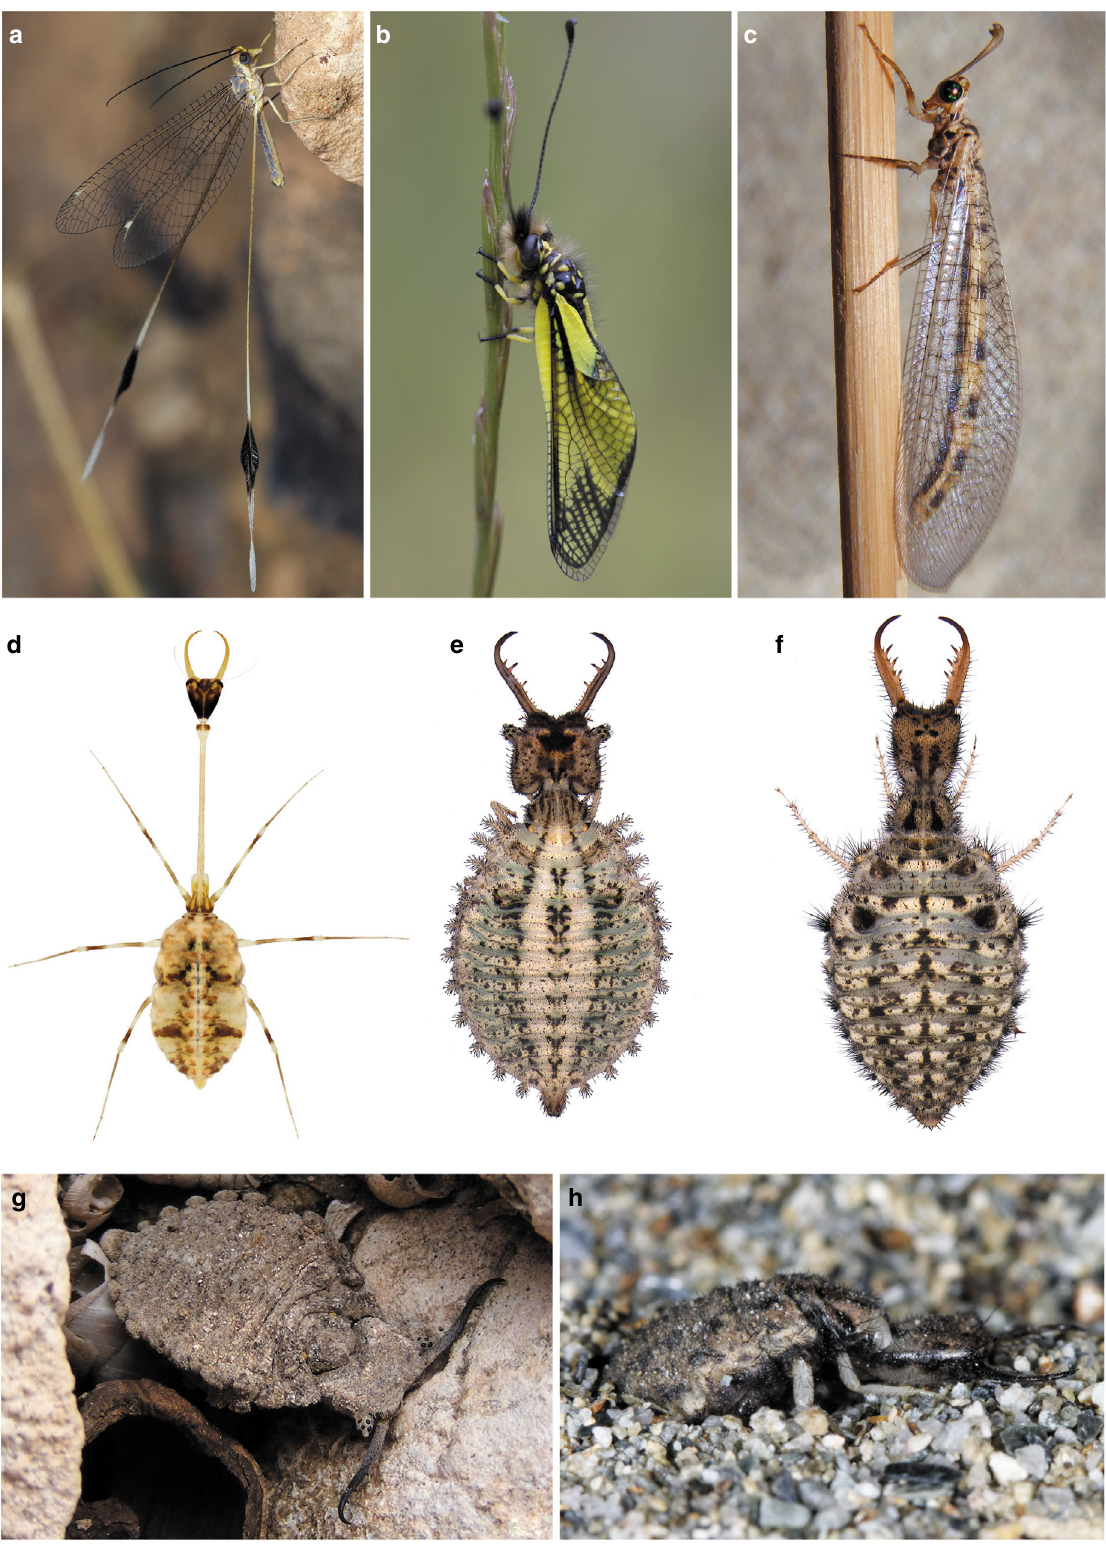
Fig. 1 Diversity and biology of extant Myrmeleontiformia. a Halter halteratus (Forskål), Nemopteridae. b Libelloides latinus (Lefèbvre), Ascalaphidae. c Myrmeleon fasciatus (Navás), Myrmeleontidae. d Larva of Pterocroce capillaris (Klug), Nemopteridae. e Larva of Libelloides latinus (Lefèbvre), Ascalaphidae. f Larva of Macroleon quinquemaculatus (Hagen), Myrmeleontidae. g Camou fl aging larva of Bubopsis agrionoides (Rambur), Ascalaphidae. h Fossorial larva of Creoleon lugdunensis (Villiers), Myrmeleontidae. Photos credits: a by Cosmin O. Manci; b , h by Claudio Labriola; c – g by Davide